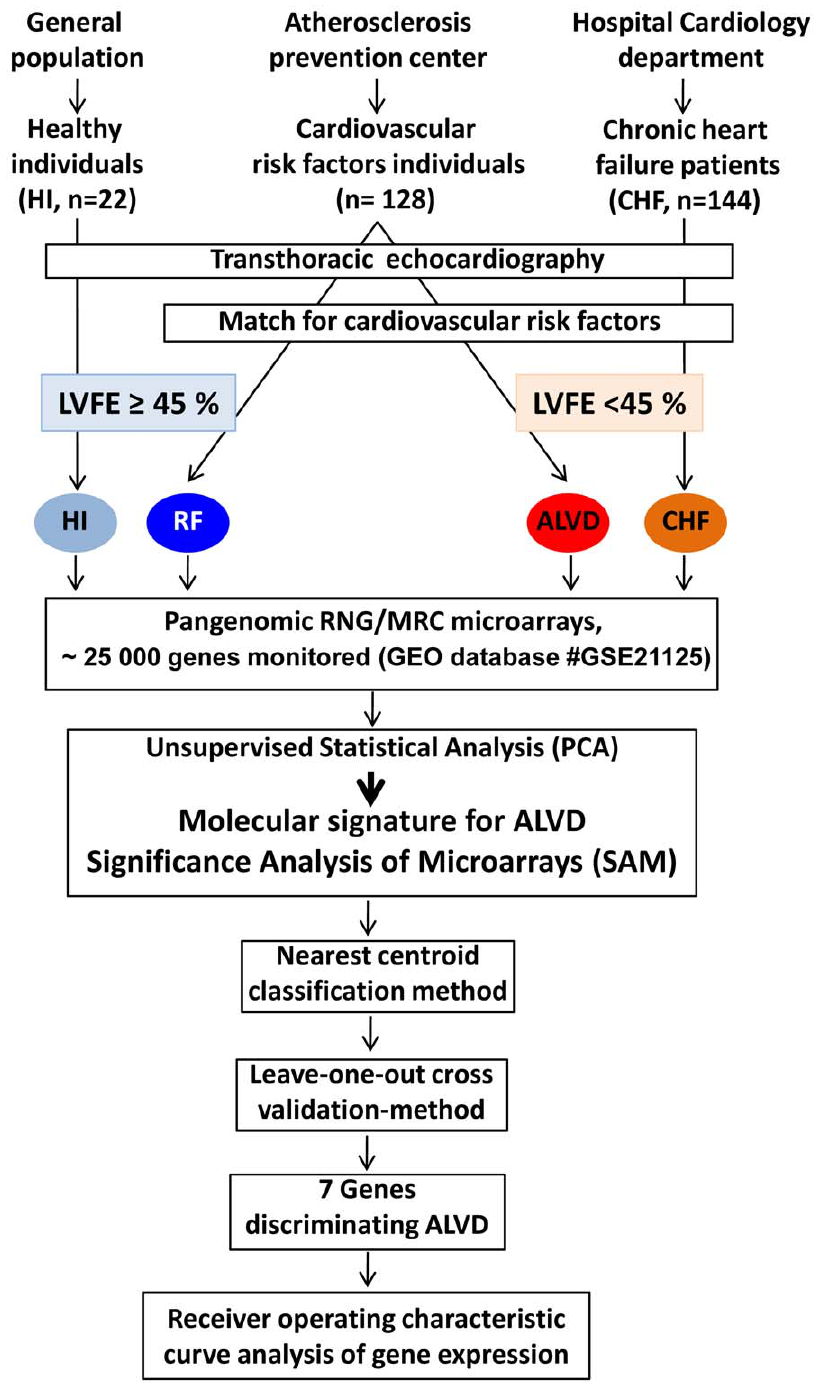
Figure 1. Flow chart of recruitment protocol involving 294 subjects and overall study design. Healthy volunteers (HI) were recruited from the general population, individuals with cardiovascular risk factors (RF) were from the atherosclerosis prevention center and patients with chronic heart failure (CHF) were recruited from the cardiology department at Rangueil Hospital, Toulouse. All subjects underwent transthoracic echocardiography for left ventricular ejection fraction (LVEF) assessment. We used a threshold value of LVEF , 45% to sort individuals into 4 groups: HI (light blue), RF with LVEF $ 45% (dark blue), ALVD (red), and CHF (orange) with LVEF , 45%. We identified 9 ALVD cases out of the 128 subjects tested with cardiovascular risk factors. We used the set of cardiovascular risk factors (age, gender, arterial hypertension, diabetes, obesity, dyslipidemia and heredity) based on the characteristics of the ALVD subjects to match the study groups (n=9). White blood cell gene expression profiling was performed using pangenomic microarrays for all 4 groups. Data were statically analyzed using unsupervised primary component analysis (PCA) and by Significance Analysis of Microarrays (SAM software) which defined the false discovery rate. Then to build an ALVD classifier model, we used the nearest centroid classification method (NCCM) with the ClaNC software package. Classification performance was determined using the leave-one-out cross-validation method. Expression levels of 7 genes capable of discriminating ALVD were compared between the 4 groups and each gene’s capability to discriminate patients with LVEF , 45% was evaluated using Receiver Operating Characteristic (ROC) analysis. doi:10.1371/journal.pone.0020414.g001 PLoS ONE |